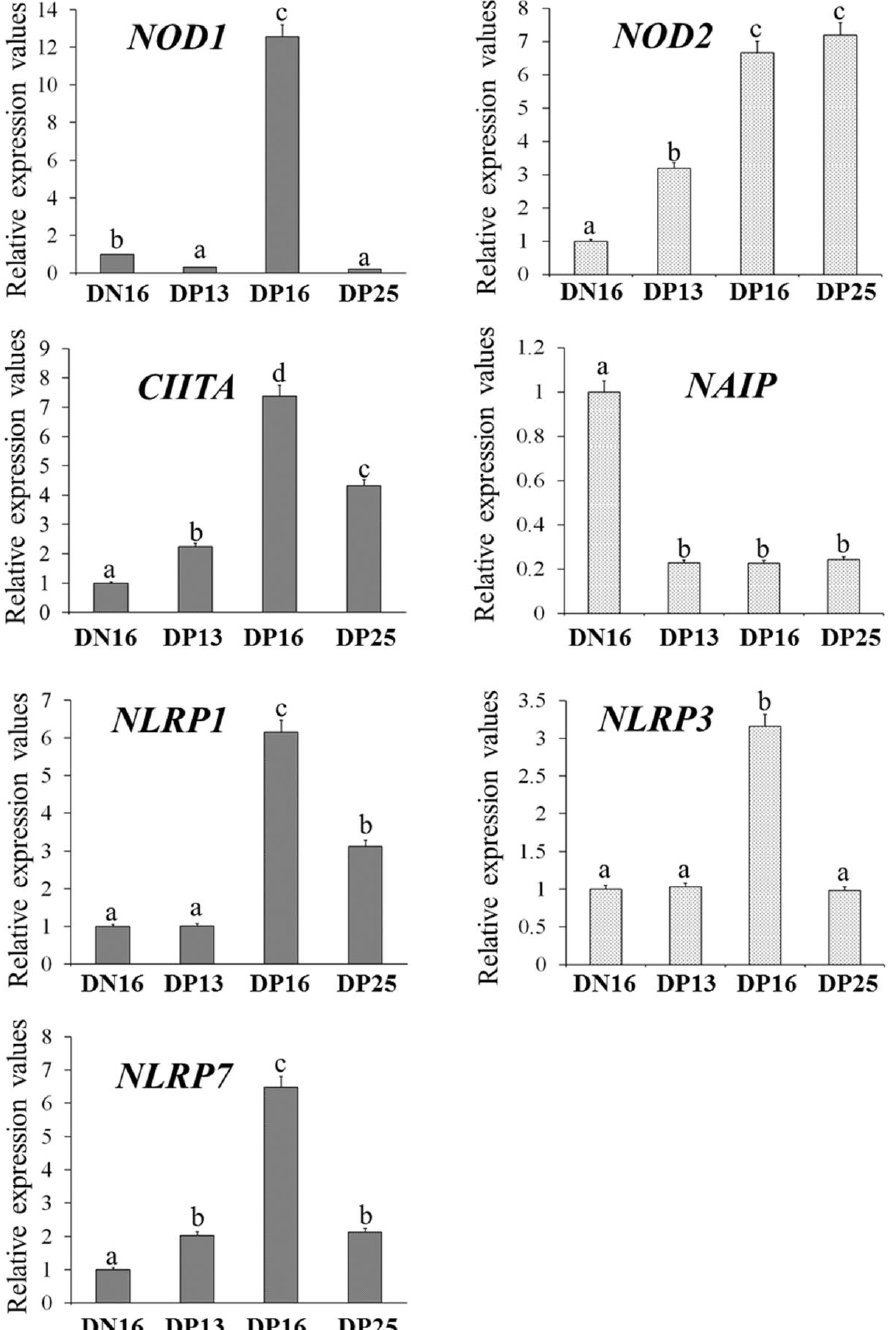
Figure 1. Relative expression values of NOD1, NOD2, CIITA, NAIP, NLRP1, NLRP3 and NLRP7 mRNA in the lymph nodes. Note: DN16 = day 16 of nonpregnancy; DP13 = day 13 of gestation; DP16 = day 16 of gestation; DP25 = day 25 of gestation. Significant differences ( p < 0.05) are indicated by different letters.